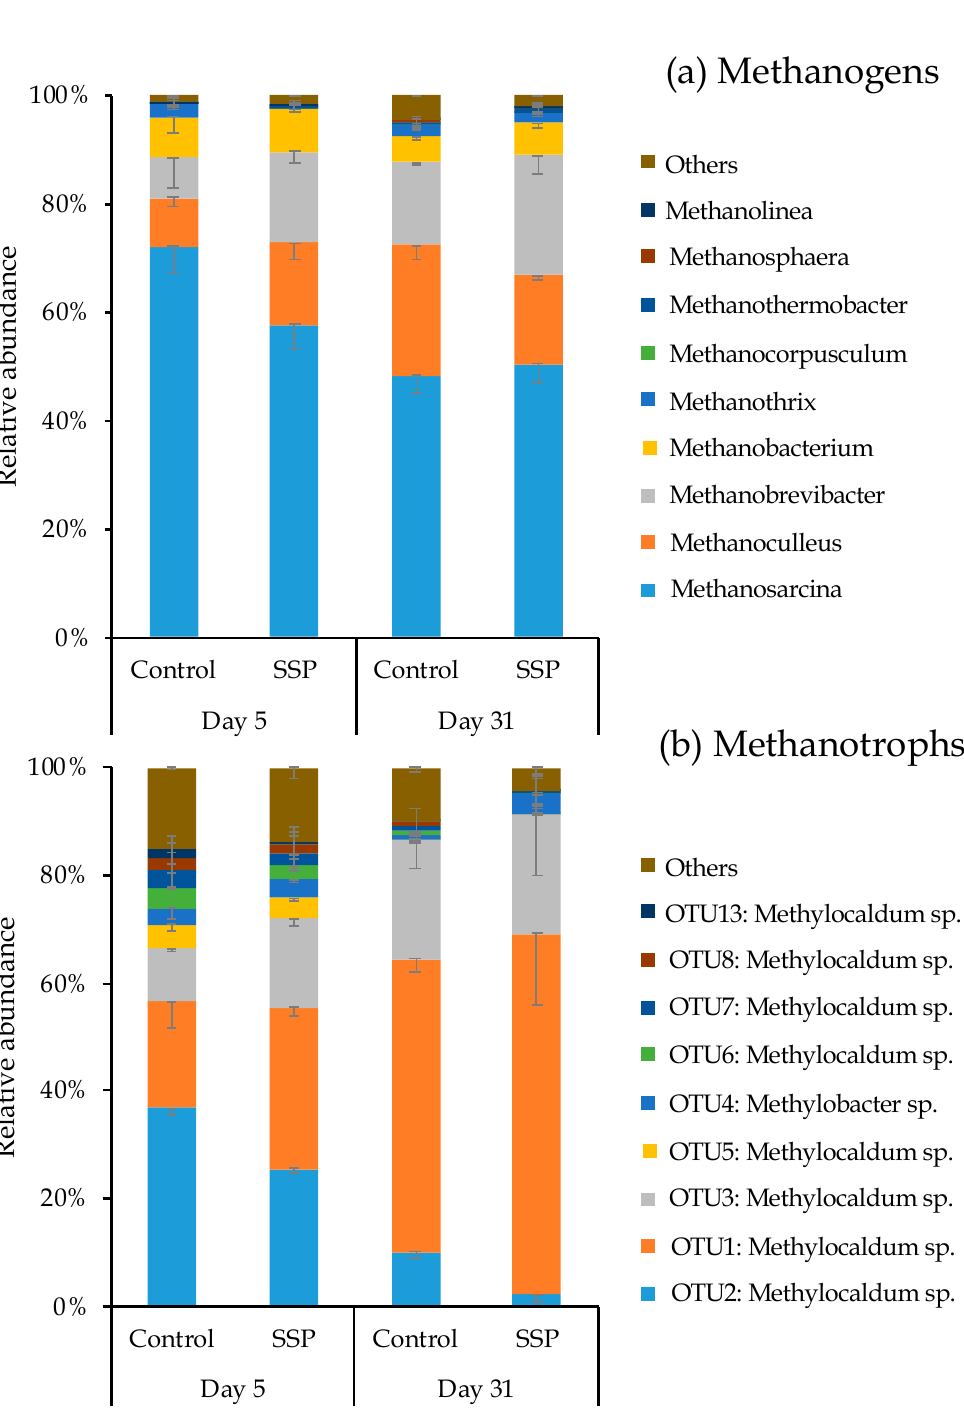
Figure 5. Relative abundance of methanogens ( a ) and methanotrophs ( b ) under different fertilization treatments. Relative abundance of methanogens and methanotrophs for the taxonomic levels of genus and OTU, respectively. Values are means ± SE ( n = 3). Treatments were defined as in Figure 1.